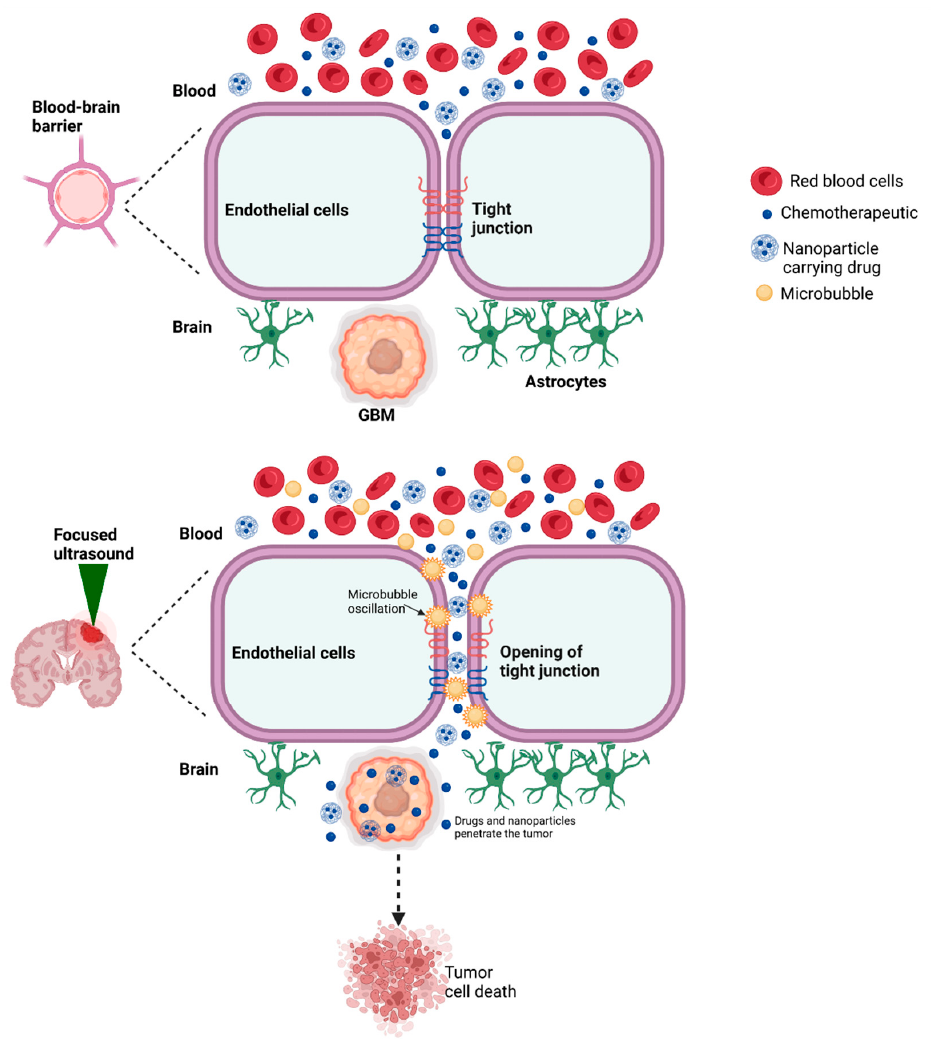
Figure 2. The BBB is a microvascular network that restricts diffusion of most molecules across the brain. The barrier includes a series of tight junctions, including occludins and claudin molecules. Application of FUS stimulates oscillations of microbubbles, producing acoustic cavitation that interferes with tight junction interactions and transiently opens the BBB. Nanoparticles and therapeutic agents can diffuse across the BBB to target the tumor. The BBB is opened only in the region stimulated by